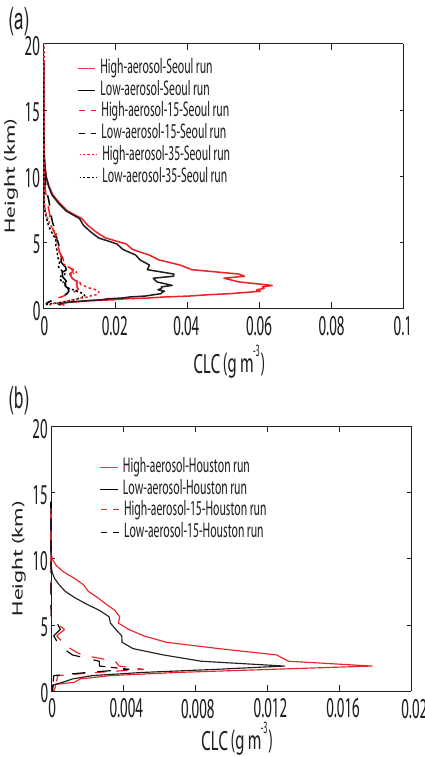
Figure 3. Vertical distributions of the time- and domain-averaged cloud liquid content (CLC) for (a) the Seoul case and (b) the Hous- ton case. Solid lines represent simulations at the 500m resolution, while dashed lines represent those at the 15km resolution. Dotted lines represent simulations at the 35km